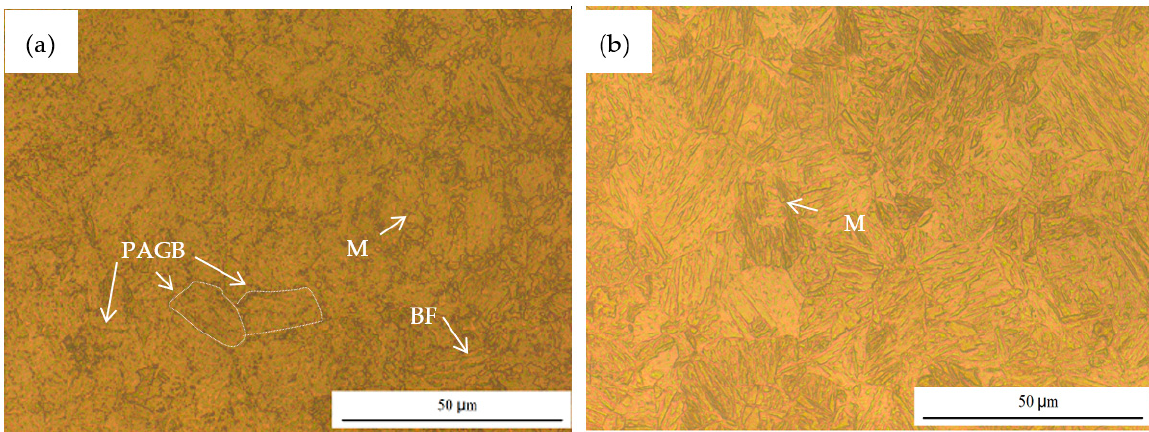
Figure 2. Optical micrographs of ( a ) heat-affected zone and ( b ) weld bead.